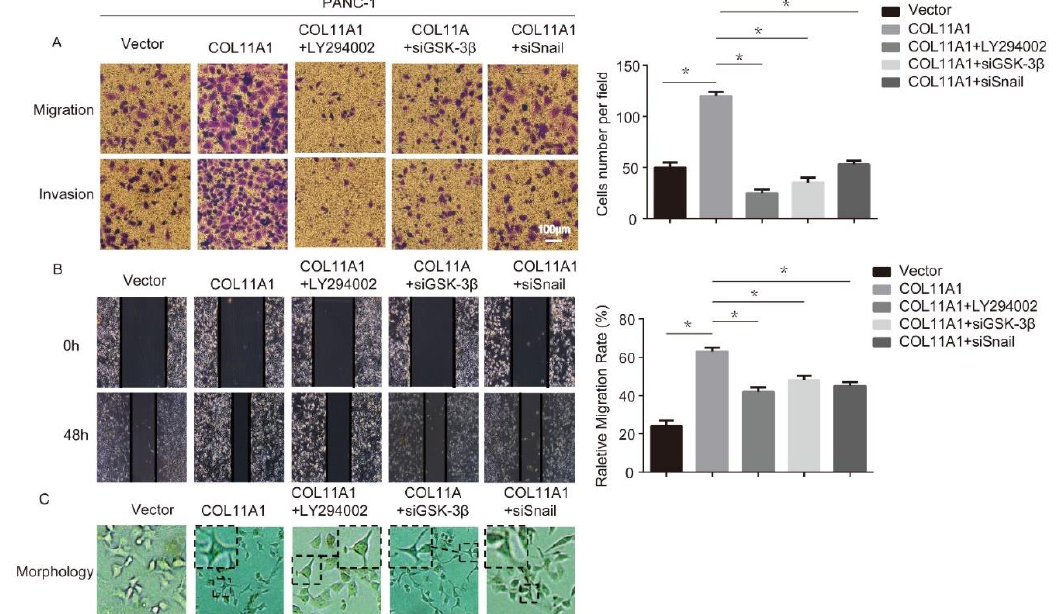
Figure 4. COL11A1 promoted the migration and invasion of pancreatic cancer cells via the Akt/GSK- 3β/Snail signaling pathway: ( A ) transwell assay was performed to detect the migration and invasion abilities of PANC-1 cells after treatment; ( B ) the migration ability of treated PANC-1 cells was tested using a wound-healing assay; ( C ) morphology of PANC-1 cells after various treatments. ( n = 3, * p <